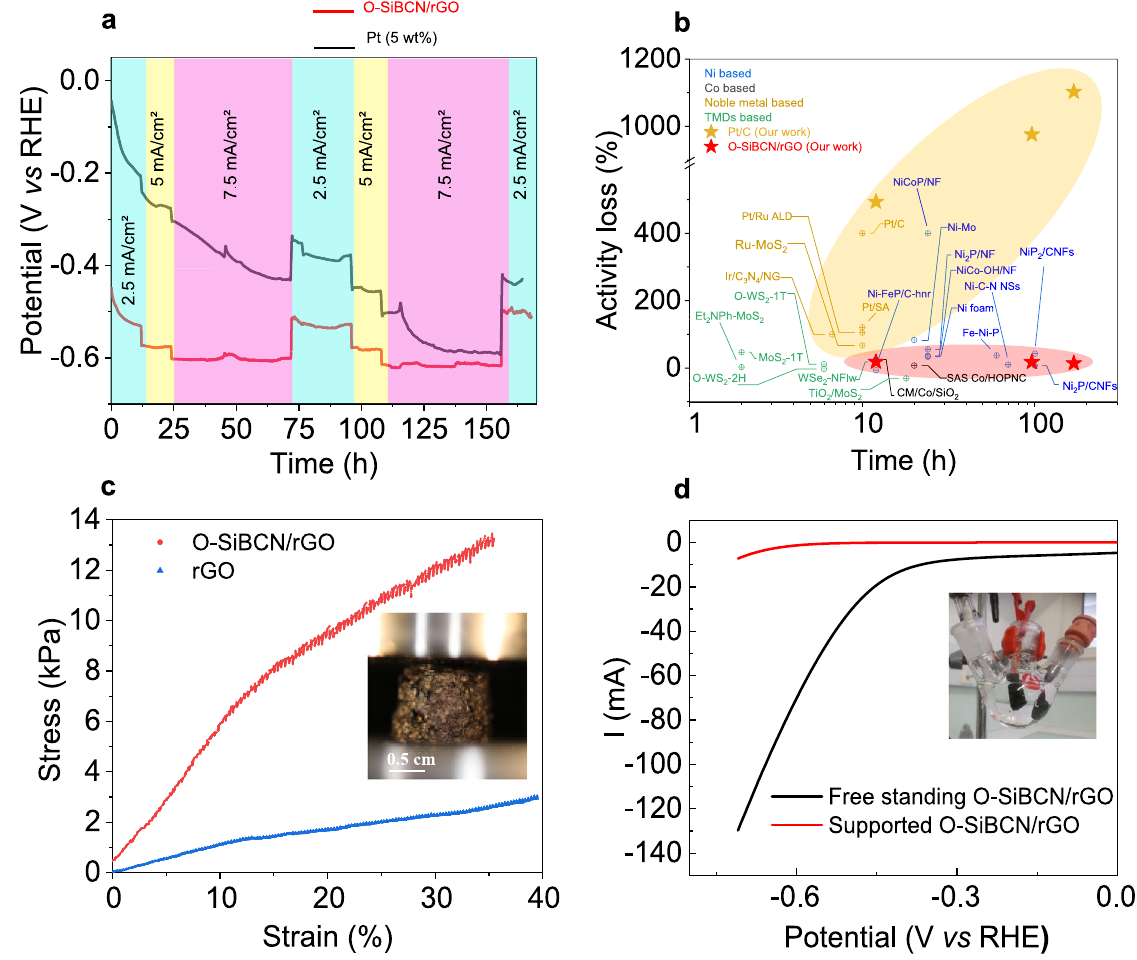
Figure 7. ( a ) Chronopotentiometry measurements for supported Pt/C electrodes and O-SiBCN/rGO composite over 168 h. ( b ) Change in overpotential (%) for O-SiBCN/rGO and other electrocatalysts in the literature: (Ni-FeP/C-hnr 62 (hnr = hallow nanorod), Ni 2 P/CNFs 63 (CNFs = carbon nanofibers), NiP 2 /CNFs 63 , Ni foam 64 , NiCo-OH/NF 64 (NF = nickel foam), Ni 2 P/NF 64 , NiCoP/NF 64 , Ni-C-N NSs 65 (NSs = nanosheets), Ni-Mo 66 , Fe–Ni-P 67 , CM/Co/SiO 2 68 (CM = carbon material) , SAS/Co/HOPNC 69 (SAS = single-atomic Co sites, HOPNC = embedded in hierarchically ordered porous N-doped carbon), Ir/C 3 N 4 /NG 70 , Pt/Ru ALD 71 (ALD = atomic layer deposition), Pt/SA 71 (SA = single atomic), Pt/C 71 , Ru-MoS 2 72 , MoS 2 1T 73 , Et 2 NPh fct MoS 2 73 , TiO 2 /MoS 2 74 , O-WS2-1T 75 , O-WS2-2H 75 , WSe 2 NFlw 76 (NFlw = nano flowers). ( c ) Compression curves of the rGO foam and the O-SiBCN/rGO composite. The inset shows that the composite remains stable after compression. ( d ) Comparison of the polarization curves from the O-SiBCN/rGO composite catalyst deposited on the glassy carbon electrode and free-standing O-SiBCN/rGO. Note that the potentials of the free-standing electrode were not iR loss